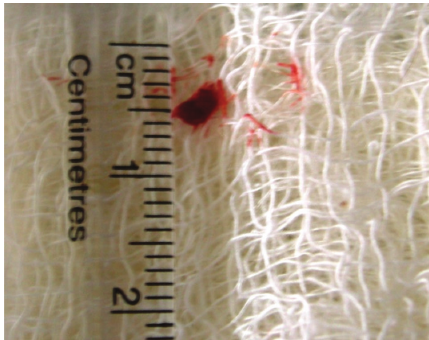
Figure 13: Laparoscopic postprocurement monitoring of liver biopsy site for bleeding in 7-year-old male mixed-breed dog with hepatic nodular hyperplasia.